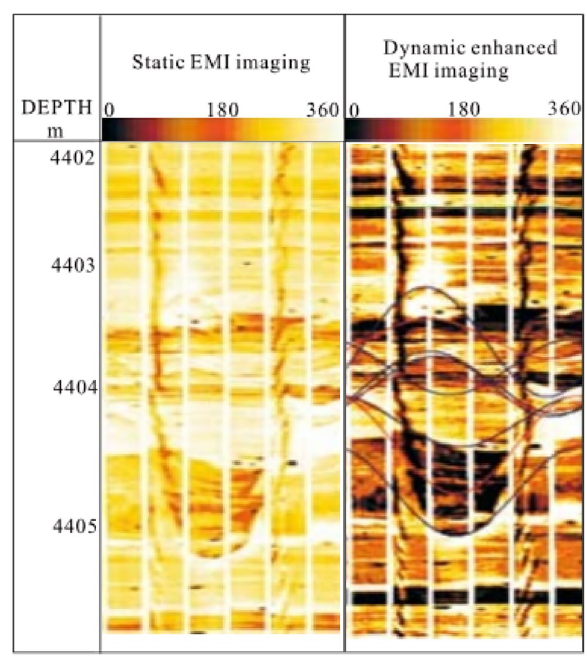
Fig. 13 The NE-SW orientation shown by the drilling-induced frac- ture with